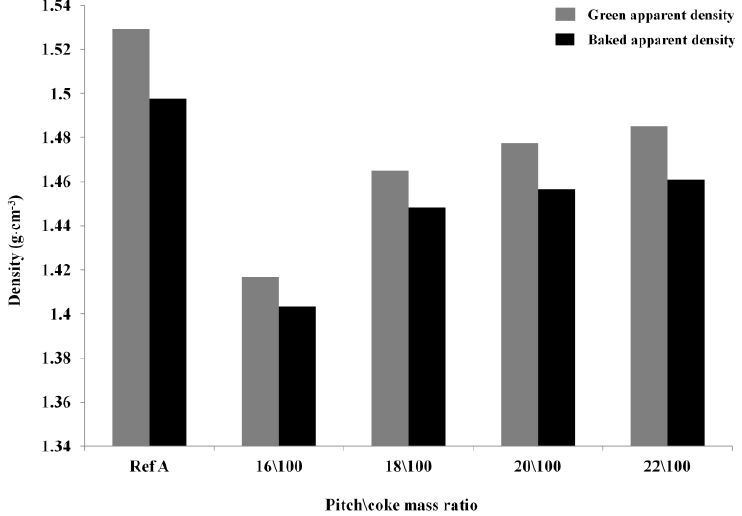
Figure 3. The influence of pitch content on the green and baked apparent density of anodes containing 10% charcoal compared to the reference anode (Ref A).